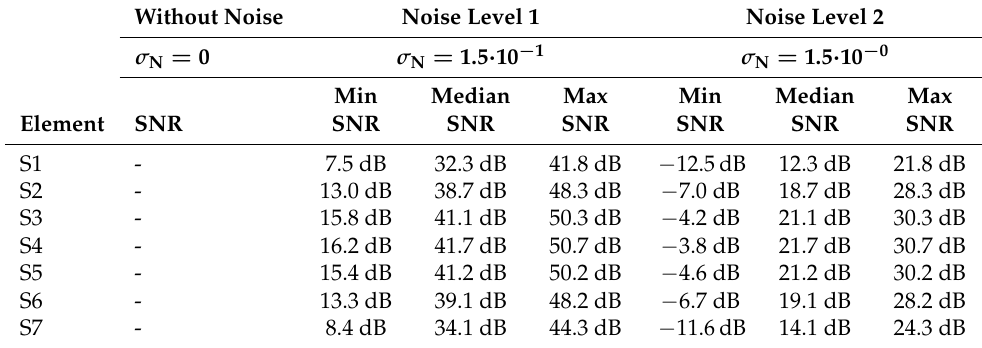
Table 1. Table with signal-to-noise ratio for strain in x direction for different elements.